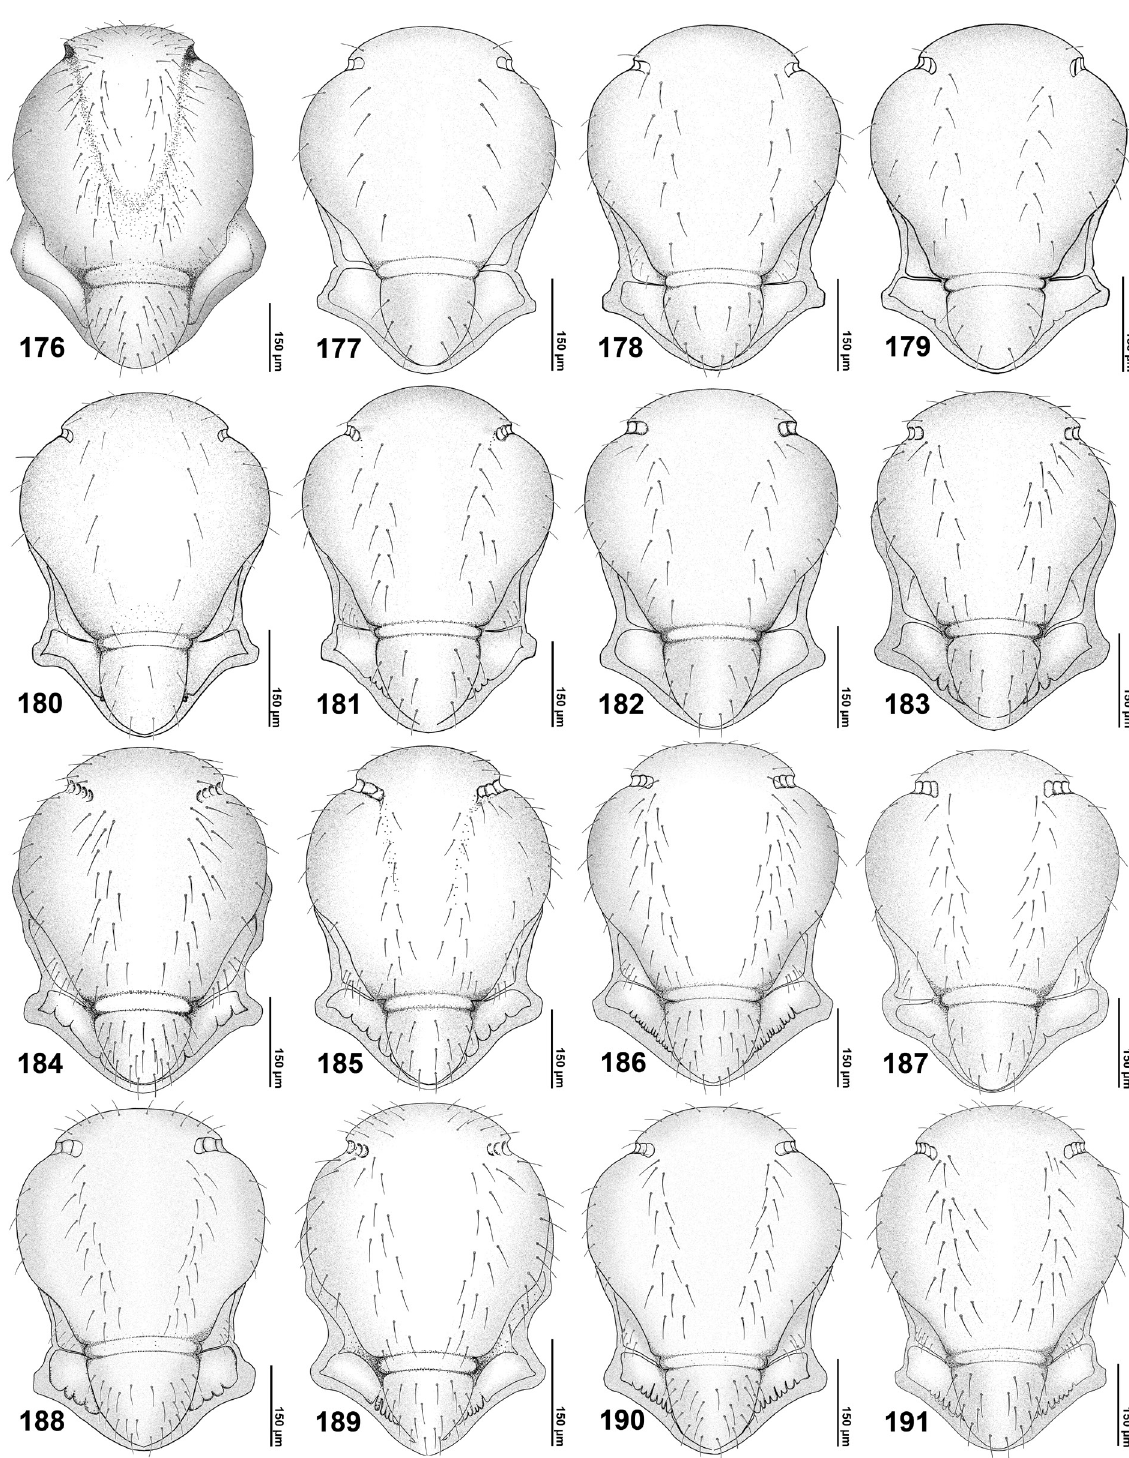
Figs 176–191. Dorsal aspect of mesonotum (♀): 176 . Aclitus obscuripennis . 177 . Adialytus ambiguus . 178 . Adialytus salicaphis . 179 . Adialytus thelaxis . 180 . Adialytus veronicaecola . 181 . Aphidius absinthii . 182 . Aphidius arvensis . 183 . Aphidius asteris . 184 . Aphidius avenae . 185 . Aphidius banksae . 186 . Aphidius cingulatus . 187 . Aphidius colemani . 188 . Aphidius eadyi . 189 . Aphidius eglanteriae . 190 . Aphidius ervi . 191 . Aphidius funebris